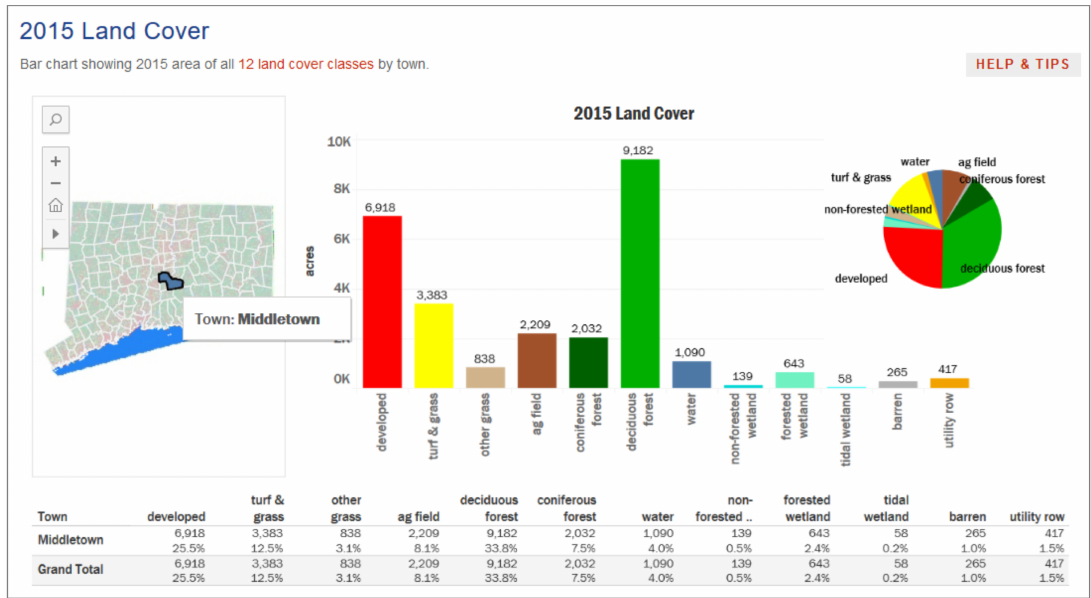
Figure 9. Visitors to the “Numbers and Charts” section of the CCL website can click or drag on a town or set of towns (left) and generate tailored graphs and tables relating land cover information. Shown here is the tool for the 2015 land cover